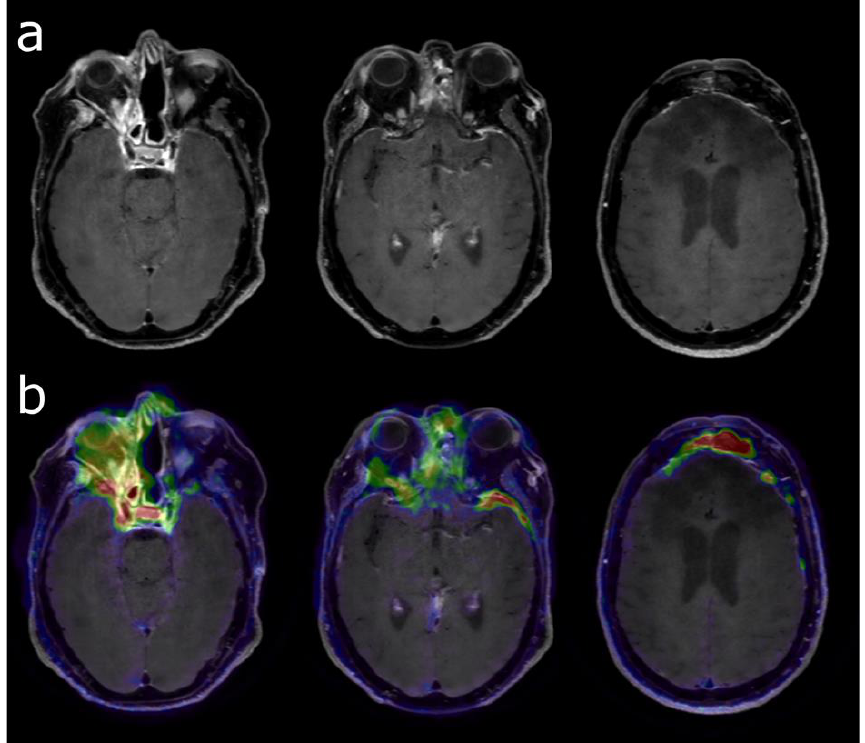
Figure 4. Post-enhancement T1-weighted MRI ( a ) before radiation therapy of a grade 2 skull base meningioma in a 49-year-old woman who was previously treated several times by surgery. [68Ga]Ga-DOTATOC PET ( b ) was performed to differentiate viable tumor (high uptake) vs. post-therapeutic changes (moderate uptake). Meningioma extension (to frontal and left temporal areas) was much more obvious using [68Ga]Ga-DOTATOC PET in addition to MRI.